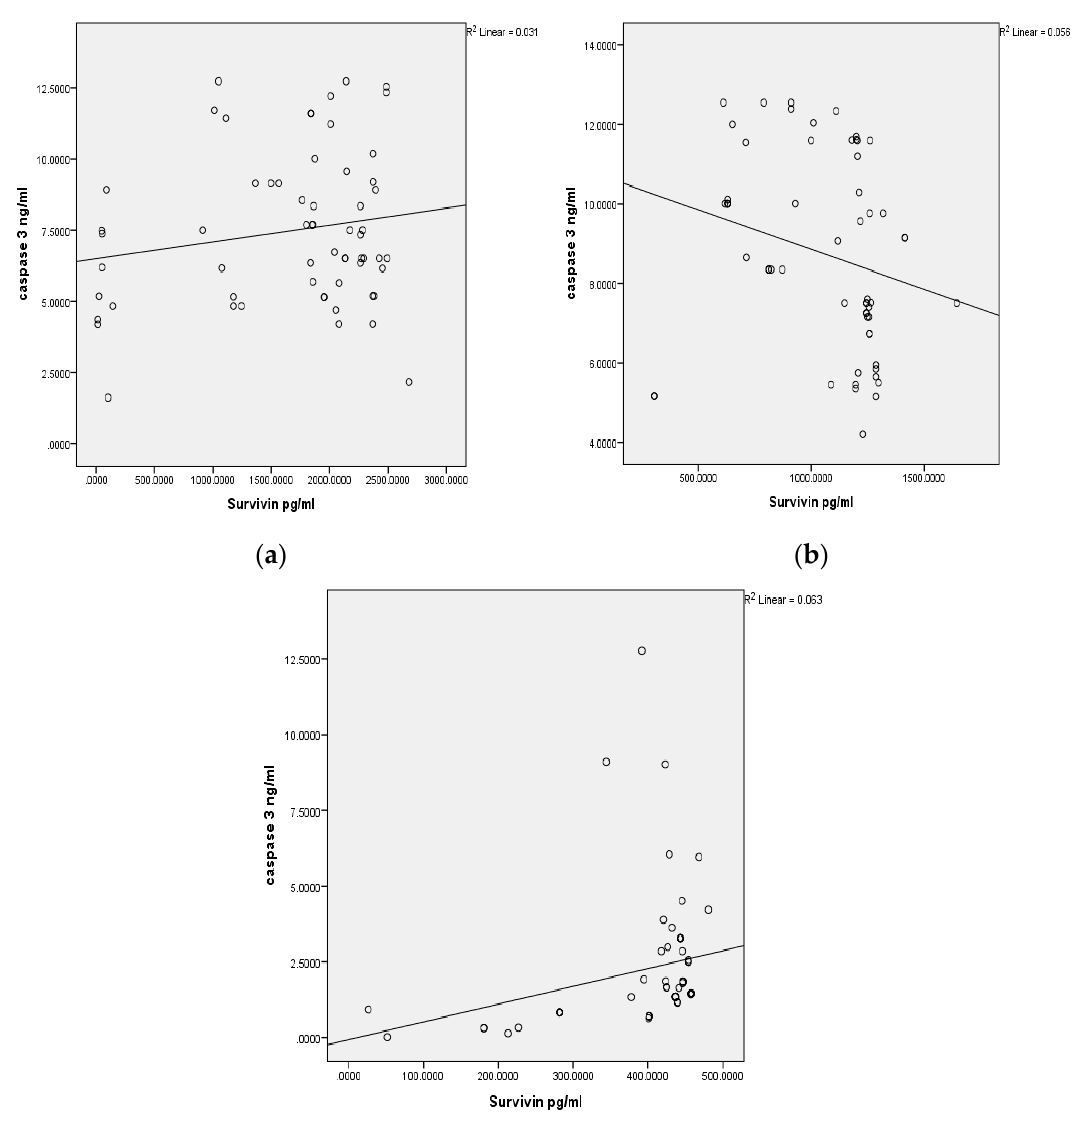
Figure 4. ( a ) Correlation analysis of the Survivin and Caspase 3 levels in tissue specimens of the OSCC patients; p = 0.174. ( b ) Correlation analysis of the Survivin and Caspase 3 levels in the buccal cell samples of the tobacco chewers; p = 0.646. ( c ) Correlation analysis of the Survivin and Caspase 3 levels in the buccal cell samples of the control subjects. There is a positive significant correlation between Caspase 3 and Survivin among the controls; p = 0.046.